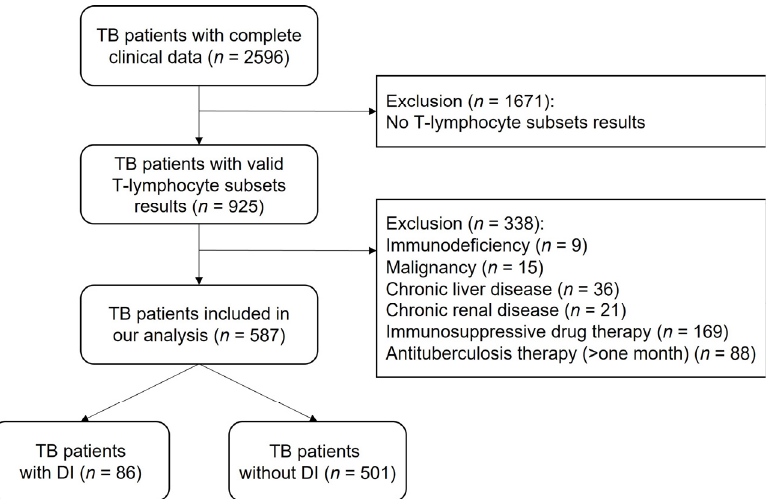
Figure 1. Flowchart of the study population.